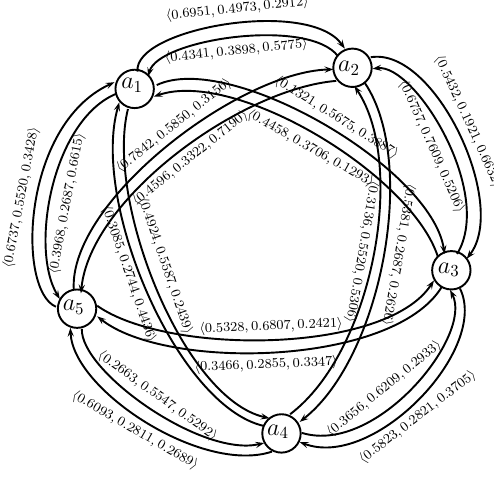
Figure 5. Directed network of the fused